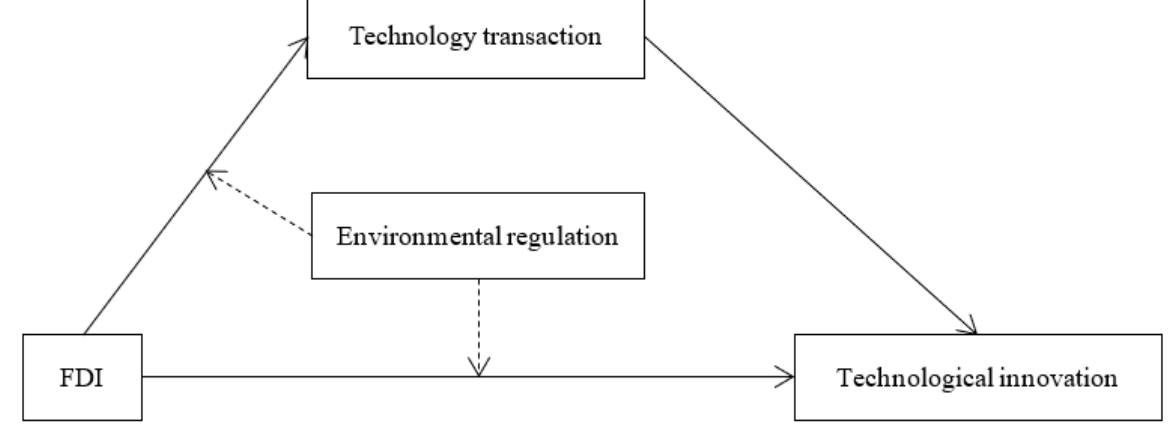
Figure 1. Conceptual model.